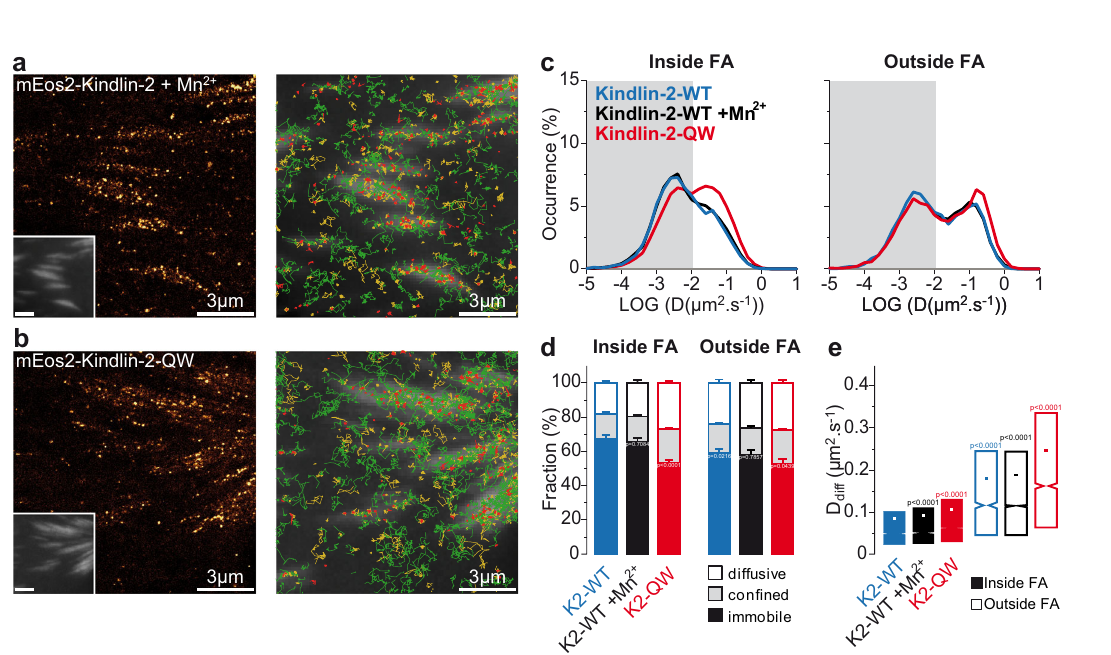
Fig. 3 Kindlin-2 interaction with integrin induces kindlin-2 immobilization, but is dispensable for kindlin-2 diffusion. Left: Super ‐ resolution PALM intensity images of mEos2-kindlin-2-WT in Mn 2 + -stimulated MEFs ( a ) and mEos2-kindlin-2-QW614/615AA in MEFs ( b ) obtained from a sptPALM sequence (50 Hz, >80 s). Inset: low resolution image of GFP-paxillin, which was co-expressed for FAs labeling (scale bar: 3 µ m). Right: color-coded trajectories overlaid on FAs labeled by GFP-paxillin (greyscale) show the diffusion modes: free diffusion (green), con fi ned diffusion (yellow) and immobilization (red). c Distributions of the diffusion coef fi cient D computed from the trajectories of mEos2-kindlin-2-WT (blue), mEos2-kindlin-2- WT in Mn 2 + -stimulated MEFs (black), mEos2-kindlin-2-QW614/615AA (red) obtained inside (left) and outside FAs (right), are shown in a logarithmic scale. The gray area including D values inferior to 0.011 µ m².s − 1 corresponds to immobilized proteins. Values represent the average of the distributions obtained from different cells. d Fraction of proteins undergoing free diffusion, con fi ned diffusion or immobilization inside (left) and outside FAs (right) for mEos2-kindlin-2-WT, mEos2-kindlin-2-WT in Mn 2 + -stimulated MEFs, mEos2-kindlin-2-QW614/615AA (same color-code). Values represent the average of the fractions obtained from several cells (error bars: SEM). e Box plots displaying the median (notch) and mean (square) ± percentile (25 – 75%) of diffusion coef fi cients corresponding to the free diffusion trajectories inside (left) and outside FAs (right). Results for mEos2-kindlin-2-WT (17 cells) and mEos2-kindlin-2- QW614/615AA (33 cells) correspond to pooled data from fi ve independent experiments. Results for mEos2-kindlin-2-WT + integrin activation by Mn 2 + (17 cells) correspond to pooled data from four independent experiments. Where indicated, statistical signi fi cance was obtained using two ‐ tailed, non ‐ parametric Mann – Whitney rank sum test. Inside and outside FAs, the different conditions were compared to the corresponding mEos2-kindlin-2-WT condition. The exact P values are indicated on the fi gure except when P < 0.0001. Source data are provided as a Source Data fi